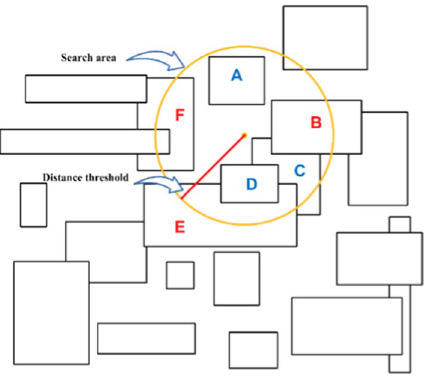
Fig. 8 Rang query operation over the MBRs layer